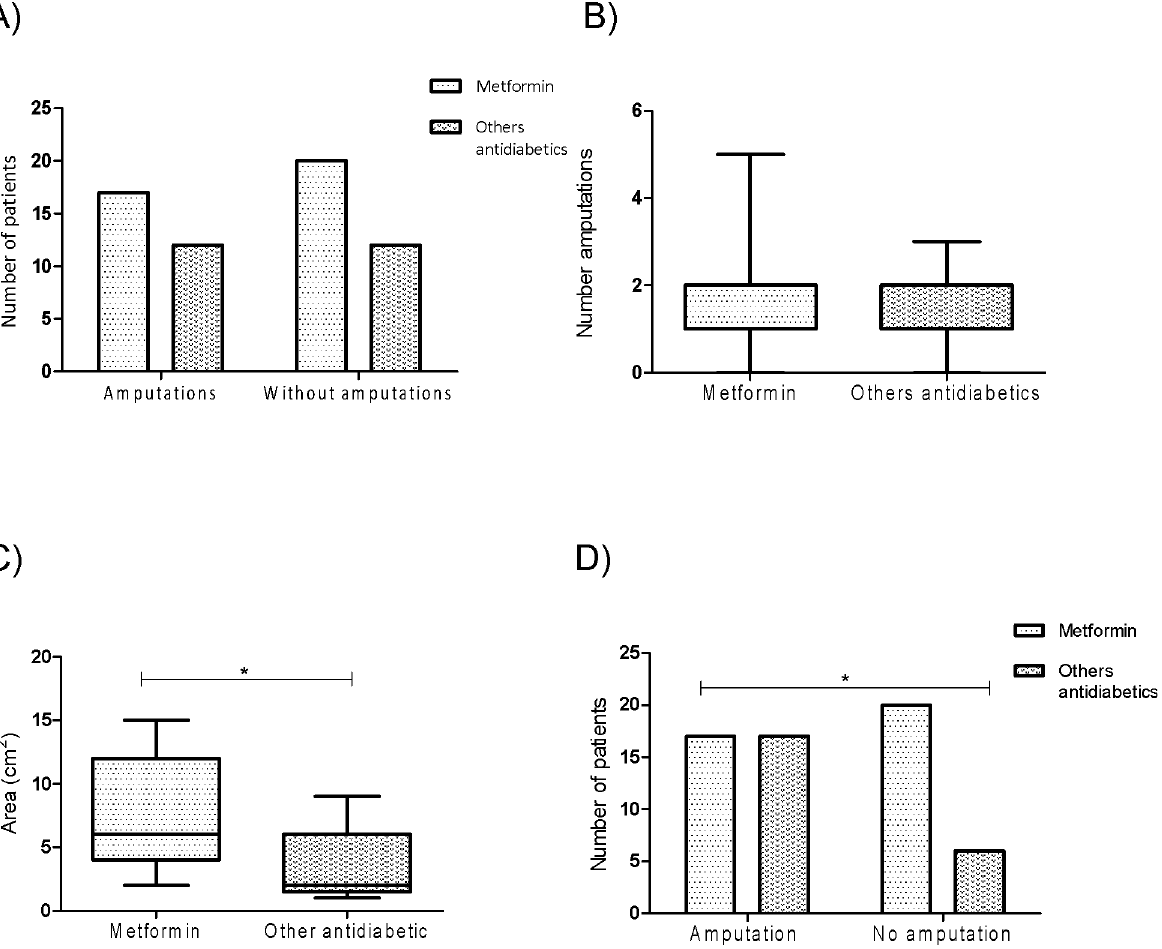
Fig 5. Effect of metformin in history of diabetic foot ulcer. Data shown was taken from the clinical records of patients who had diabetic foot ulcer and stratified by treatment with metformin or others antidiabetic drugs (n = 72). (A) The graph shows patients at the time of the review of the record had already undergone some amputation. (B) The graph shows the number of previous amputations per treatment group. (C) The graph shows the area of ulceration reported by the treating physician, the size of ulcers is greater in the group of patients receiving metformin as part of their treatment for glycemic control (p = 0.029, Mann Whitney test). (D) The graph shows whether patients discharged from the hospital were amputated as a result of the severity of his ulcer, seen as the proportion of subjects amputees is higher in the group of patients treated with other antidiabetic drugs (p = 0.035 Fisher´s exact test). P < 0.05 was considered statistically